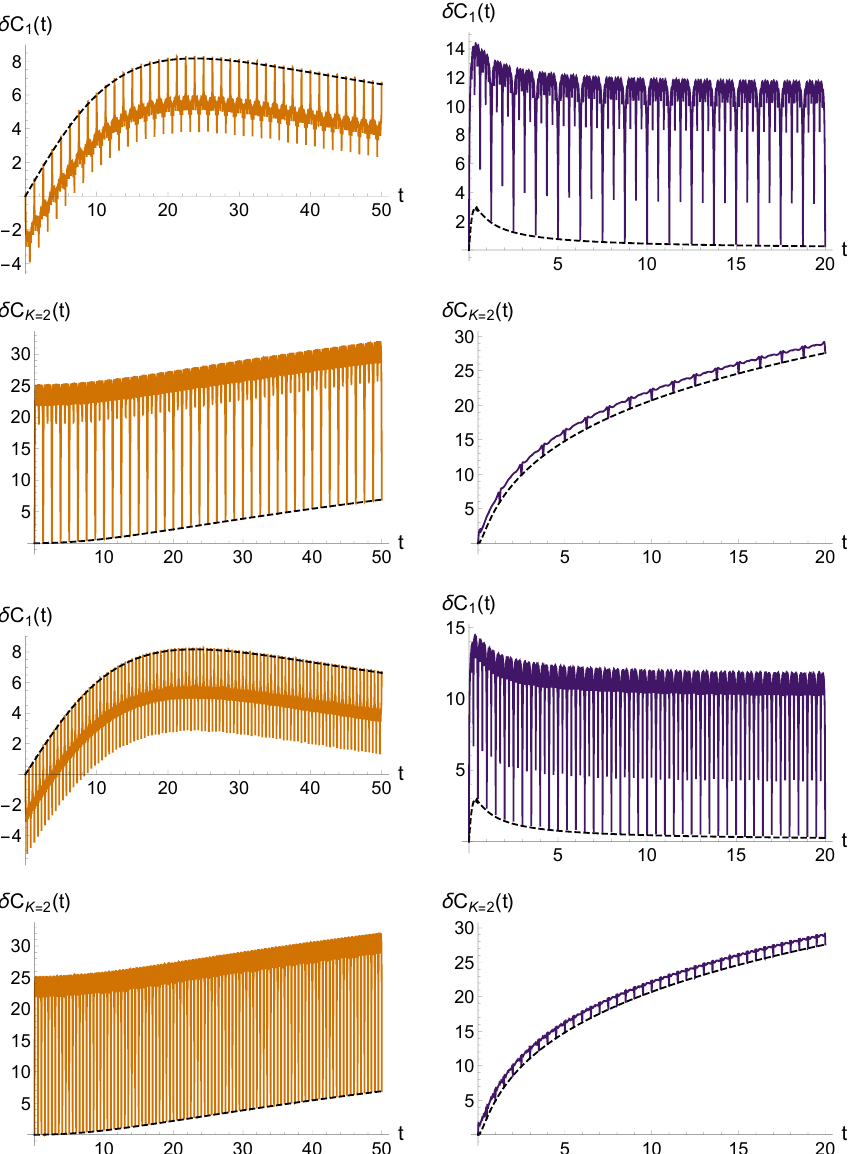
Figure 29 . Complexity variation δ C ( t ) obtained time-evolving with H + Ω J (first two rows) and H (last two rows). The plots have been produced choosing L = 1 , N = 200 , m = 10 − 6 , Ω = 0 . 6 , T = 10 , as in the central panels of figure 23. The left panels show the result for µ = 0 . 1 , and the right panels for µ = 10 . While the periodicity of the oscillations is independent from µ , the amplitude is clearly affected by